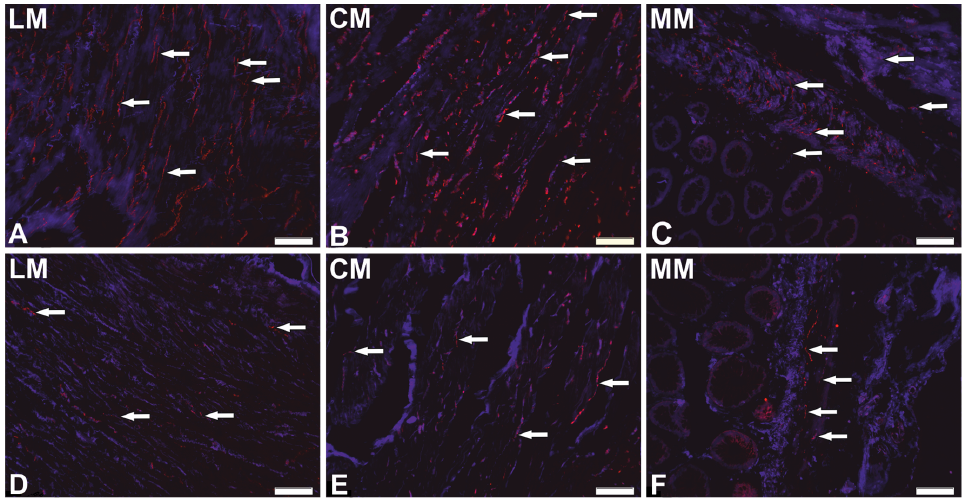
Figure 3. Distribution pattern of nerve fibers (arrows) immunoreactive to CART within longitudinal muscle (LM) and circular muscle (CM) layers, as well as lamina muscularic mucosa (MM), in control ( A – C ) and cancer-affected ( D – F ) areas of the human colonic wall. Scale bar = 100 µm. There were no differences between control and cancer-amended tissues in both the number and morphology of such nerve fibers (Table 2). However, in the control tissue, the least nerve fibers per area unit ( p < 0.05) were found in LM (0.011 ± 0.002/µm 2 ) in comparison both to CM (0.031 ± 0.004/µm 2 ) and MM (0.046 ± 0.014/µm 2 ). Changes in the density of muscular innervation were observed in carcinoma-affected tissue, where the number of nerve fibers in LM (0.014 ± 0.002/µm 2 )